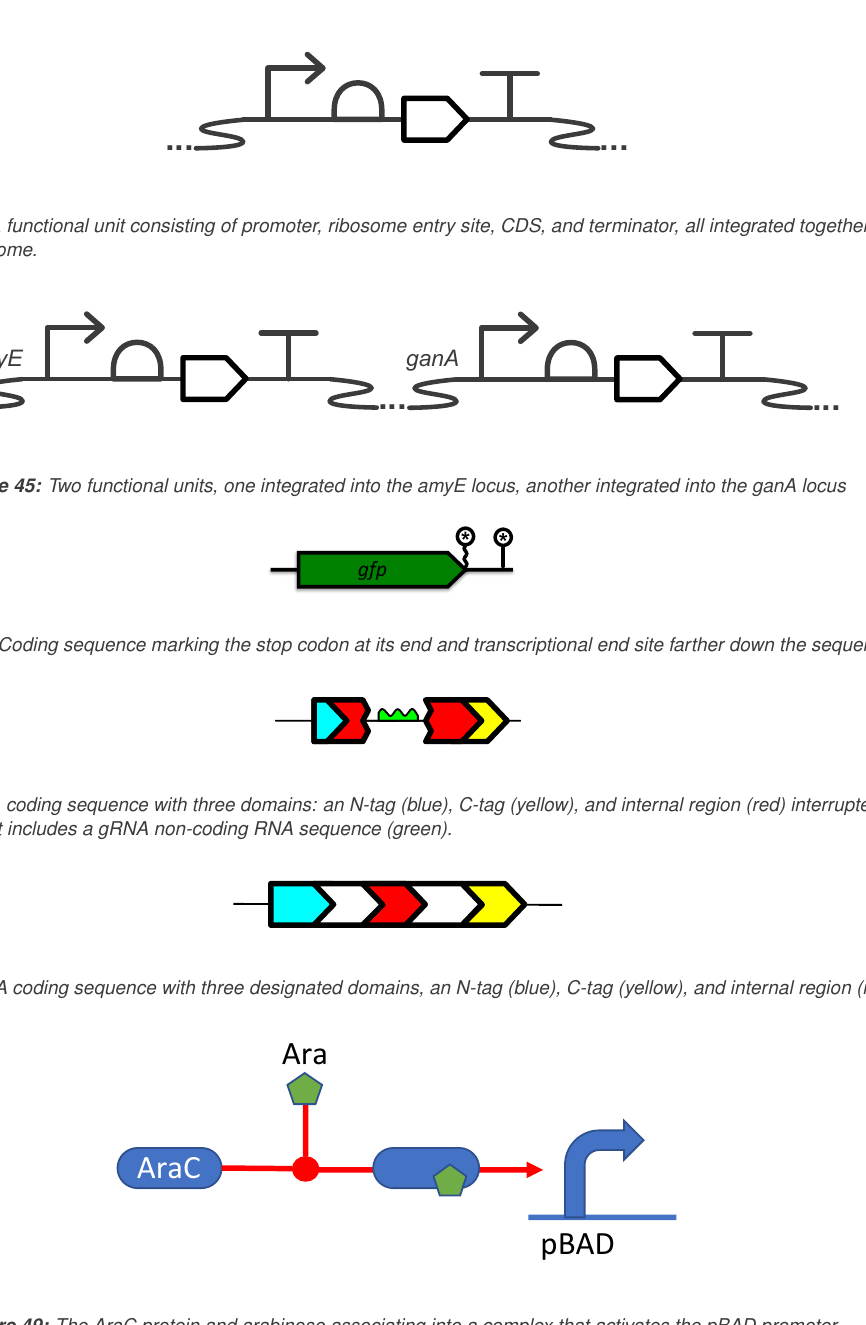
Figure 43: A circular plasmid containing a functional unit consisting of promoter, ribosome entry site, CDS, and terminator.